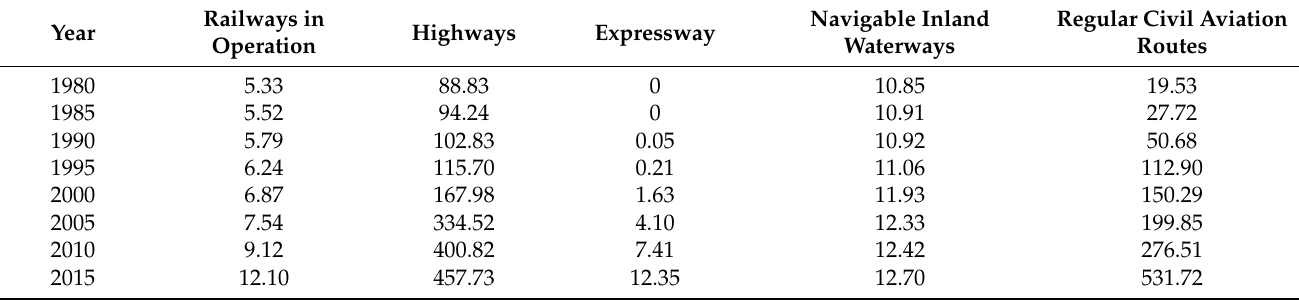
Table 2. Length of China’s TI from 1980 to 2015 (10,000